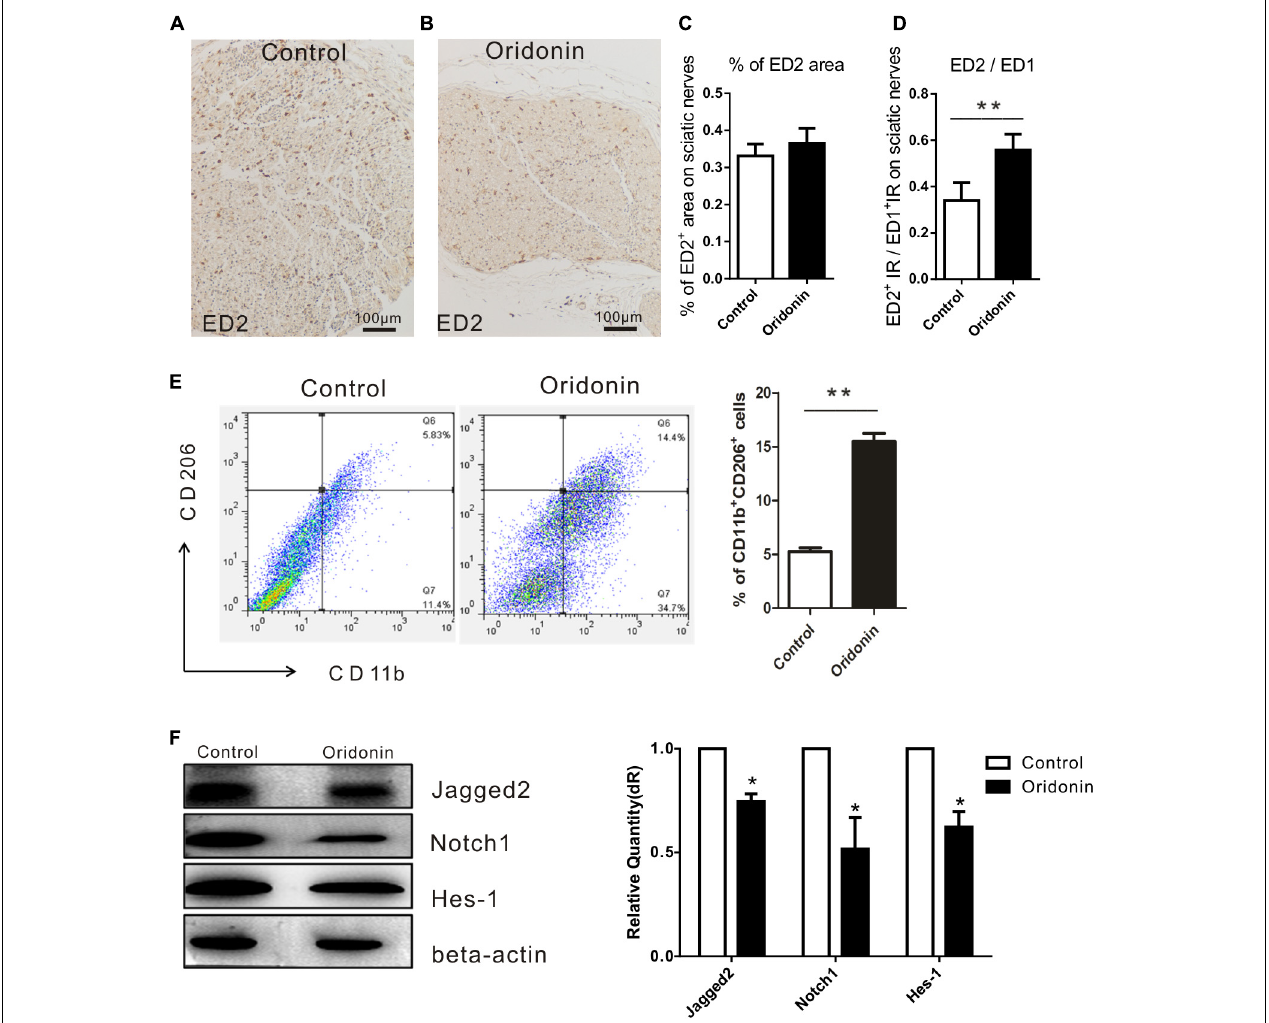
FIGURE 5 | Oridonin increased proportion of anti-inflammatory macrophages in EAN rats through suppression of Notch pathway. Rats were treated therapeutically with Oridonin and sacrificed on Day 15; sciatic nerves were taken for immunohistochemical staining. By staining, anti-inflammatory macrophages were identified by expression of CD163, which is detected by ED2 antibody. Representative microphotos show ED2 + cells in sciatic nerves of EAN rats treated by Oridonin (B) in comparison to the control (A) . In the control group, much more infiltrates could be observed, but CD163 expression was not significantly different from the treatment group, where much less accumulated immune cells could be seen. (C,D) : The bar graphs show no difference in CD163 IR levels between control and Oridonin groups, but the proportions of ED2 + over ED1 + IR areas in sciatic nerves were significantly increased in comparison to controls. Further, the frequency of CD206 + CD11b + cells from spleen were tested by flow cytometry. (E) Spleen mononuclear cells (MNCs) were isolated from the control and Oridonin treated EAN rats at day 15 post-immunization and examined by flow cytometry. Percentage of anti-inflammatory macrophages (CD206 + CD11b + cells) in spleen MNCs was significantly increased in Oridonin treated rats compared to the control group. (F) On day 15, sciatic nerves of each rat were harvested for Western blotting. Relative expression of Jagged-2, Notch1 and Hes-1 in Oridonin-treated groups was significantly lower compared to the control group. ∗ p < 0.05, ∗∗ p < 0.01 compared to the control group, n =